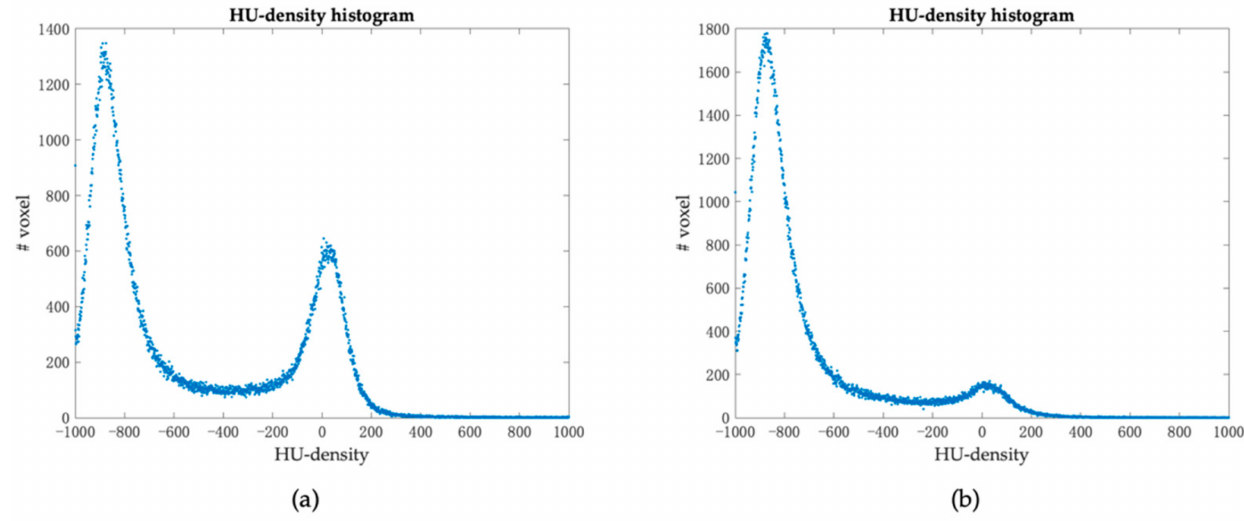
Figure 1. Examples of Hounsfield unit (HU)-density histograms. The histograms shown correspond to the lungs of the same patient; in particular, ( a ) is the histogram relating to the right lung and ( b ) is the histogram relating to the left